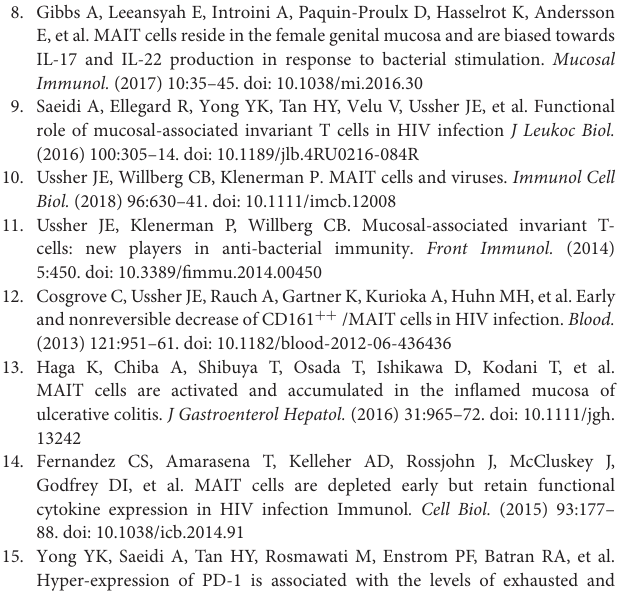
Supplementary Figure 1 | (A) Representative Facs plots showing the staining pattern of tetramers 6-FP and 5-A-RU from two SHIV-naïve rhesus macaques. (B) Distribution of MR-1 tetramer within different T cell subsets; CD8 expressed > 94% MR1. (C) Representative Facs plots showing the frequency of MAIT cells and relative levels of transcription factor PLZF in tissues between MAIT and non-MAIT cells. (D) Facs plot showing the MR-1 staining pattern in liver. (E) Representative flow plots showing the staining pattern/induction of MR-1 + CD161 + CD8, MR-1 + TCR7.2 + CD8T cells after anti-CD3/anti-CD28 stimulation with and without the addition of cytokines in SHIV-naïve animals. (F) Plots showing the cumulative data for the frequency of MAIT cells (MR-1 + CD161 + cells) after anti-CD3/anti-CD28 stimulation with and without the addition of different cytokines ( n = 2). (G) Plots showing the frequency of proliferating (Ki-67 + ) MAIT cells (MR-1 + CD161 + cells) after anti-CD3/anti-CD28 stimulation with and without the addition of different cytokines ( n = 2). IL-7 seems to enhance the proliferation of MAIT cells in SHIV-naïve animals. Supplementary Figure 2 | (A) Representative Facs plots showing the staining pattern of tissue-resident markers CD69 and CD103 on rectal MAIT and non-MAIT cells from a SHIV-infected RM. (B) Plots showing the positive correlation between the Th17 cells (CCR6 + CD4 + T cells) vs. MAIT cells in SHIV-infected macaques. (C) Representative Facs plots showing the staining pattern on MR-1 vs. CD161 from five SHIV-infected macaques. (D) Representative Facs plots showing the production of cytokines (IFN- γ , TNF- α , IL-17, IL-22, IFN- γ + TNF- α + , and IL-17 + IL-22 + cells) by IL-18R + and IL-18R-ve MAIT cells during chronic SHIV infection in an animal. (E) IL-18R expression did not show any difference in IFN- γ + or IL-17 + single positive cytokine ( n =